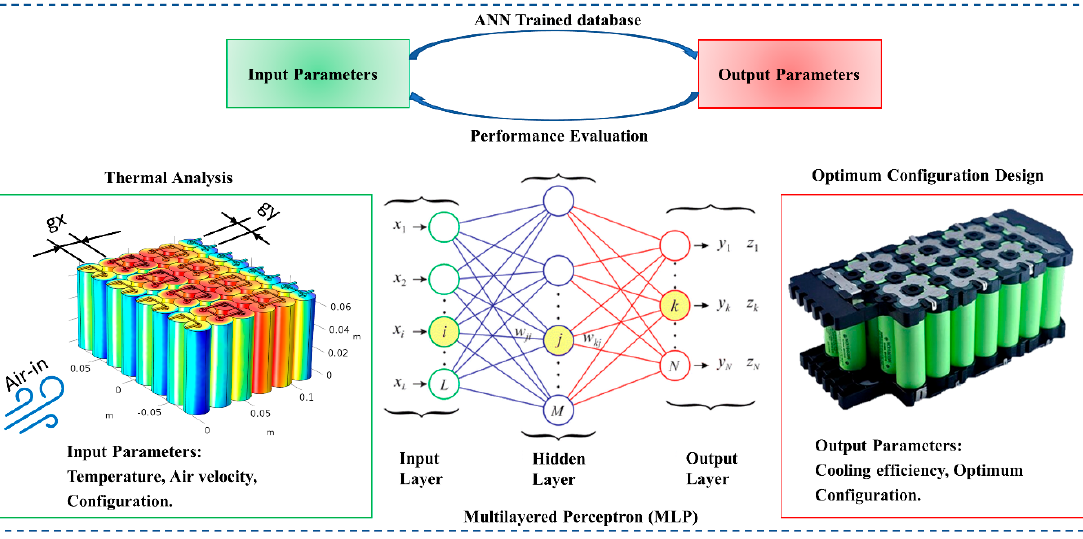
Figure 1. Schematic of the proposed CFD-ANN model.